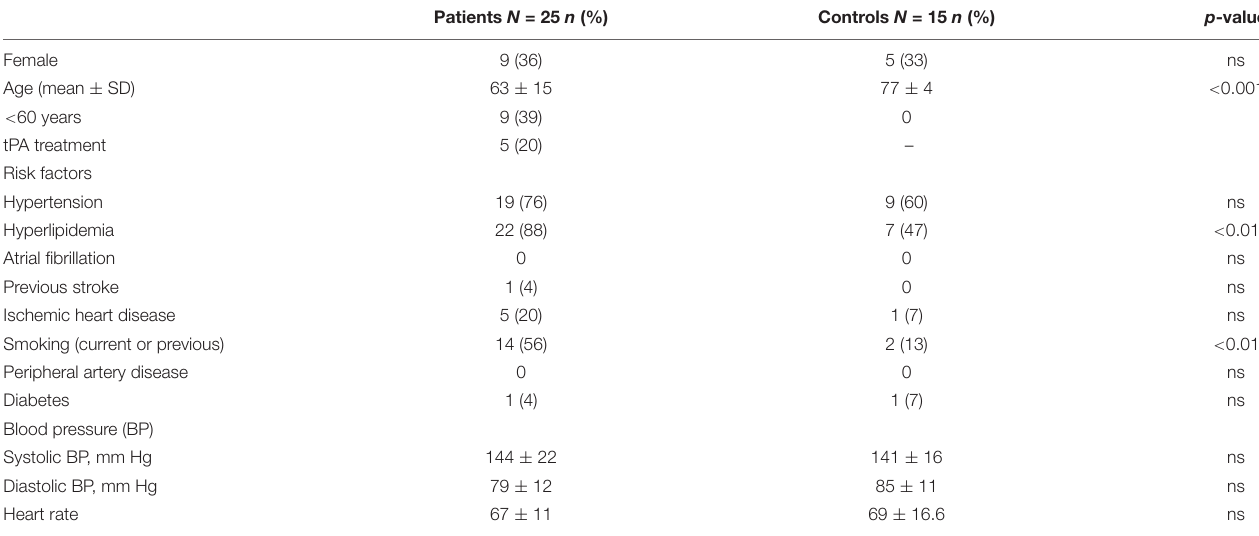
TABLE 1 | Characteristics of patients and controls.